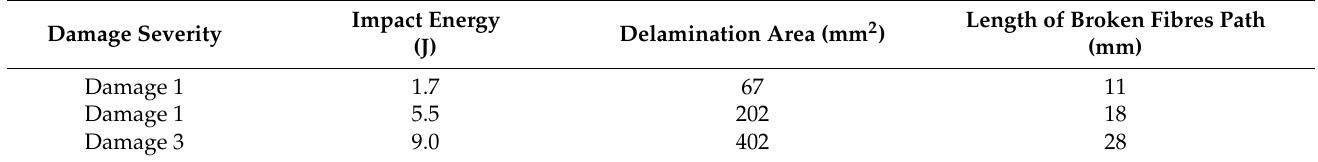
Figure 2. X-ray images of the three examined damage severities. Table 1. Main damage features measured at the three examined damage severity